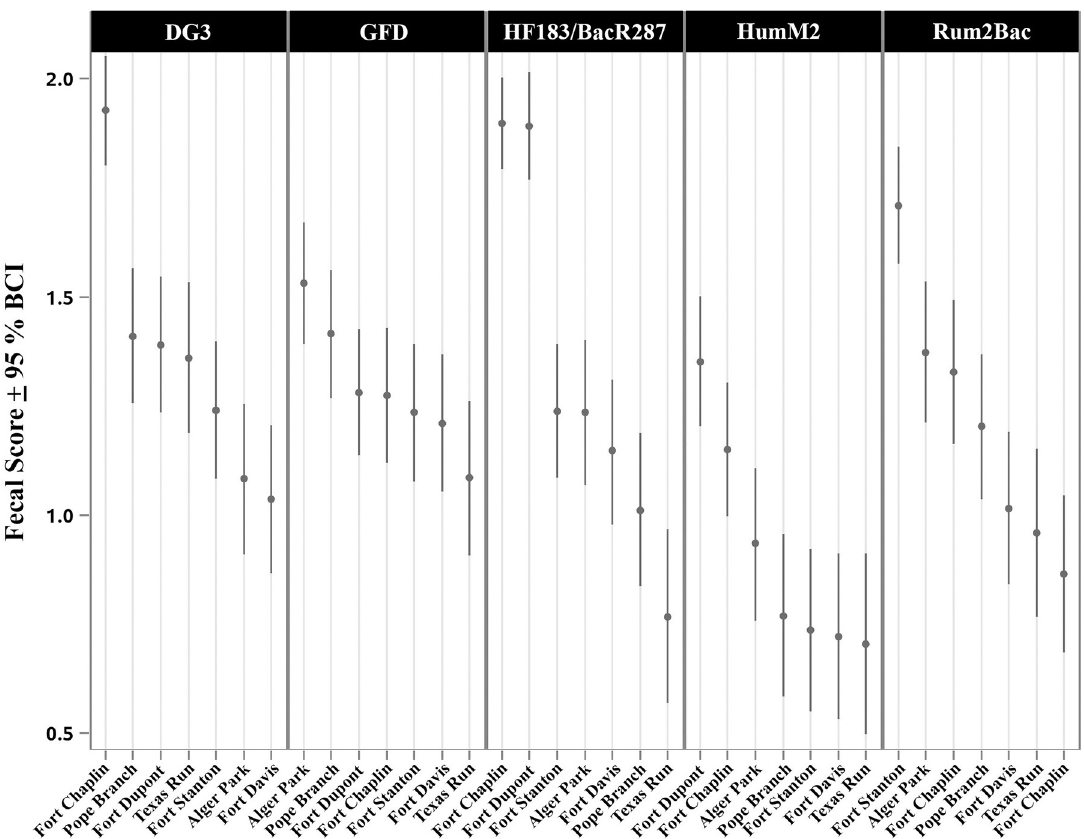
Fig 5. Fecal scores (log 10 copies per 100 ml with 95% BCI) for site rankings with each host-associated genetic marker. Values are ranked from highest (left) to lowest